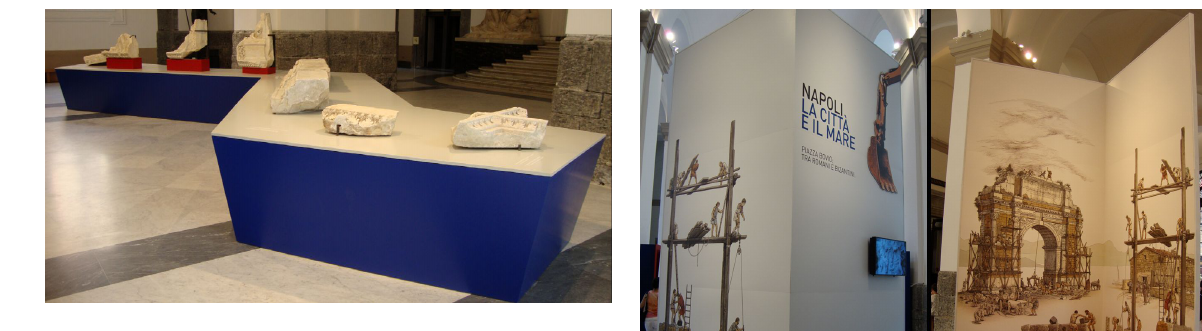
Figure 15: Napoli, Museo Nazionale, exhibition “Naples, city and sea”. Communication of the results of archaeological discoveries are still made in traditional way. This often happens because there aren’t the economic resources. Figure 17: Napoli, Museo Nazionale, exhibition “Naples, city